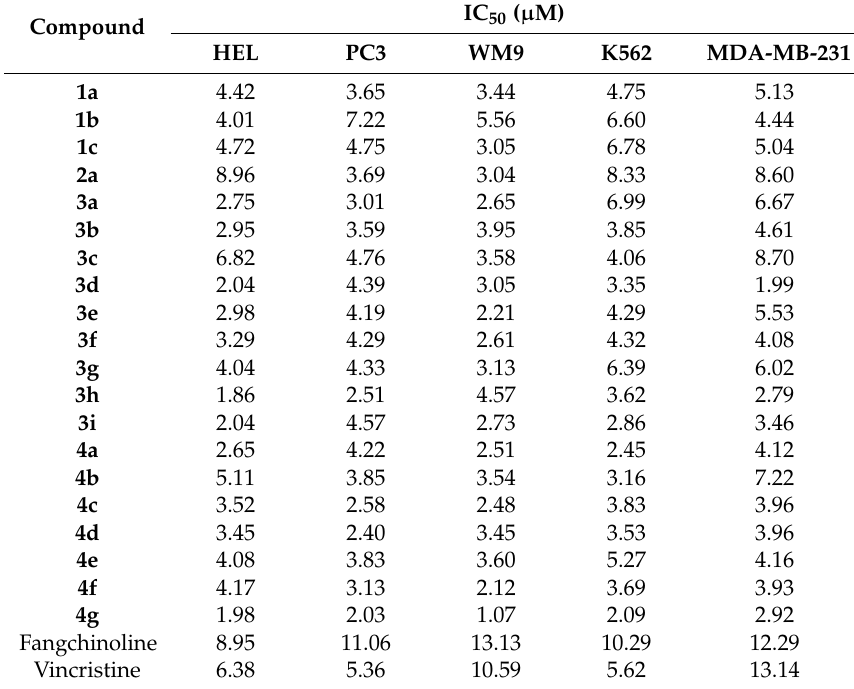
Table 1. The IC 50 values of fangchinoline derivatives 1 – 4 against the growth of 5 cancer cell lines.